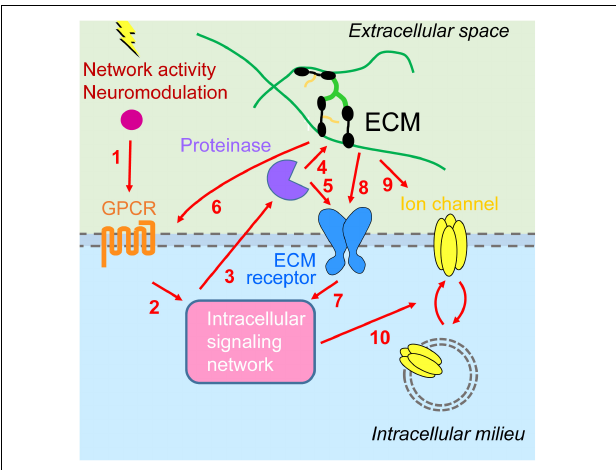
FIGURE 2 | Interplay between metabotropic receptors and extracellular matrix in homeostatic plasticity. (1) Network activity and neuromodulatory systems stimulate G protein-coupled receptors (GPCRs) [metabotropic glutamate receptors 1/5 (mGluR1/5), D1/5 dopamine receptors, 5-HT7R serotonin receptors] and (2) downstream signaling networks [including calmodulin-dependent protein kinase II (CaMKII), protein kinase A (PKA), protein kinase C (PKC), and inositol trisphosphate receptors (IP 3 Rs)]. (3) This results in activation of extracellular proteinases [tumor necrosis factor- α -converting enzyme (TACE), disintegrin and metalloprotease with thrombospondin motifs 4/5 (ADAMTS4/5), matrix metalloproteinase 9 (MMP9)], which (4) may process ECM molecules (lecticans) or (5) ECM receptors (NPR, CD44), enabling synaptic modifications (not shown) as well as (6) signaling back through modulation of GPCRs (group III mGluR) and (7) additional intracellular signaling events. (8) Inactivity increases cell surface expression and signaling through major extracellular matrix (ECM) receptors, β 3 integrins. (9) Activity stimulates secretion of Narp and its coaggregation with GluAs on interneurons. (10) Intracellular signaling cascades are converging on regulation of trafficking of GluAs [homeostatic synaptic plasticity (HSP)] or voltage- and Ca 2 + -gated ion channels